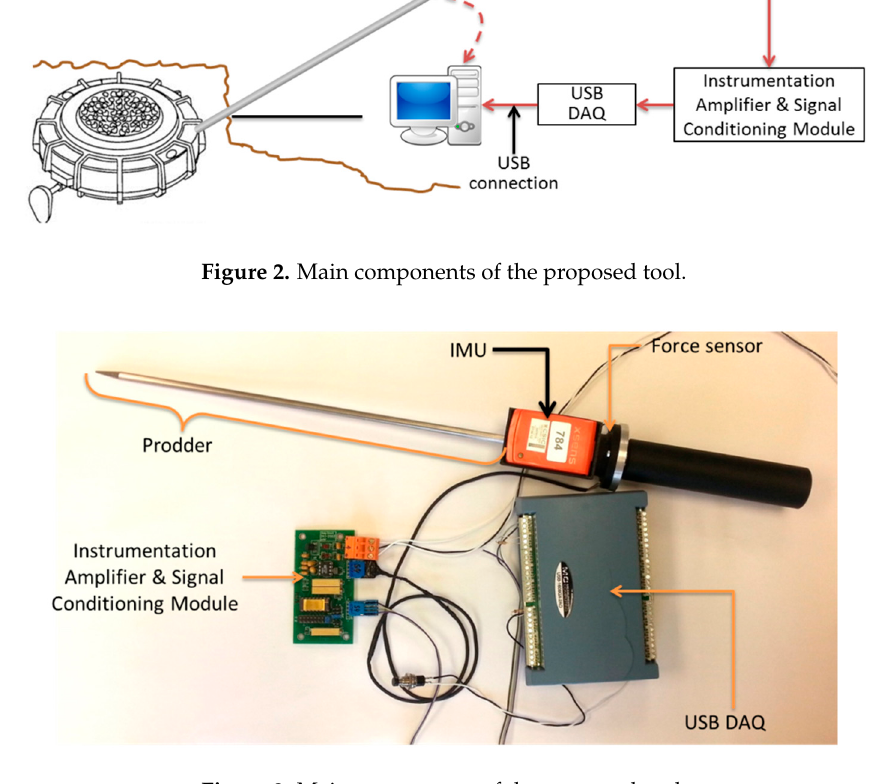
Figure 4. HMI for the intelligent feedback prodder. 2.1. Configuration This section provides the possibility of loading different configuration files for modifying the objectives of the training session (reference values for the force exerted and the insertion angle of the prodder) according to the soil type and the kind of target to be detected (see Figure 4). Thus, for instance, in highly compact, hard or rocky soil, objectives are set to achieve an approach at a shallow angle. Force reference values are defined taking into consideration the type of mine, its dimensions and its activation load or activation pressure [16,23,24].